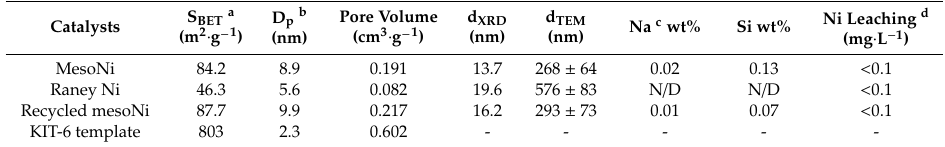
Table 1. The structural and chemical properties of ordered mesoporous Ni and related Ni-based catalysts and templates. Catalysts